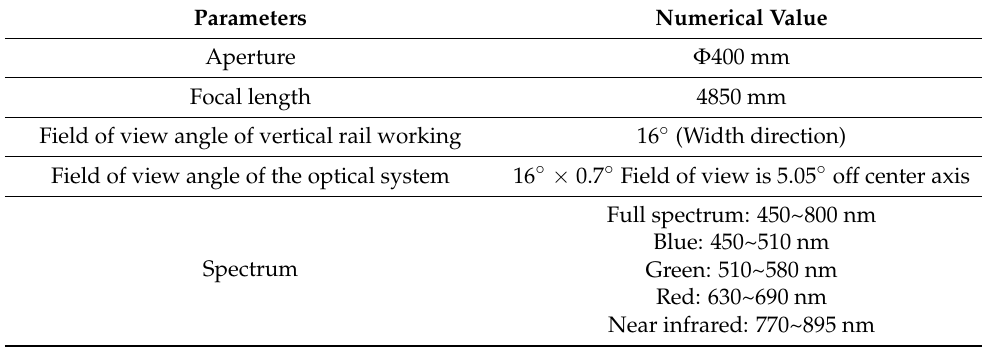
Figure 1. Structure drawing of off-axis three-mirror anastigmatic (TMA) space camera. Table 1. Parameters of space camera.